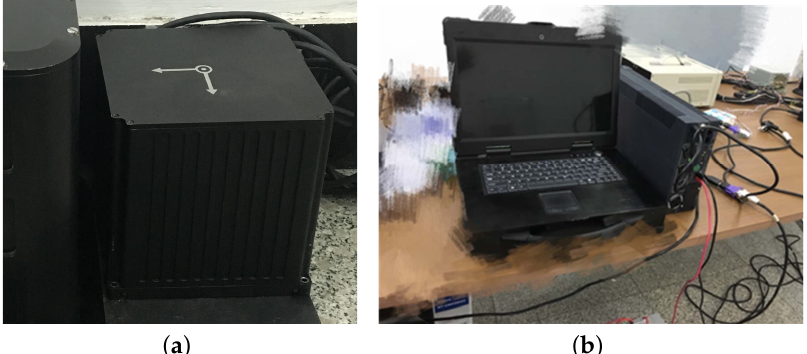
Figure 4. Static test in the laboratory. In this test, a FOG IMU, developed by the Navigation Instrument Institute, Harbin Institute of Technology, is used as shown in ( a ). This FOG IMU is placed on a stable and leveled marble platform to isolate the influence from external disturbance; In ( b ), a rugged laptop is used to collected the source